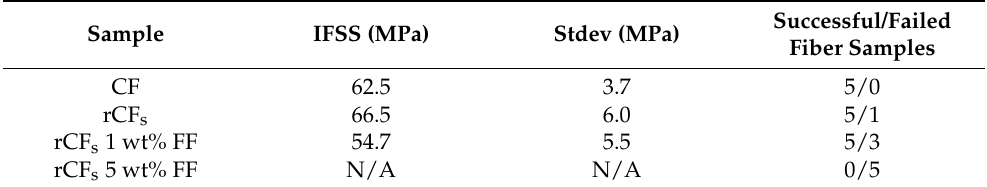
Table 2. IFSS results and standard deviation (stdev) of CF and rCFs in PA6. The last column presents the number of successfully tested fiber samples versus fibers that failed during testing. Sample IFSS (MPa) Stdev (MPa)